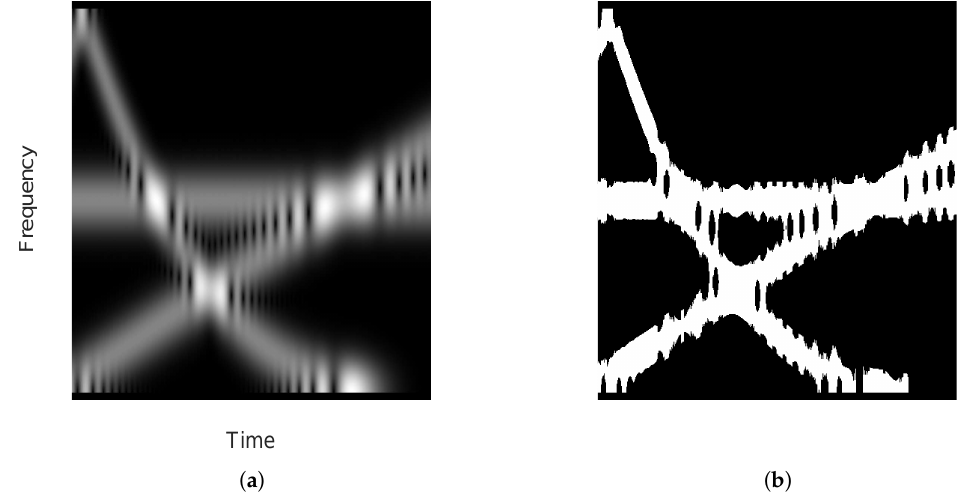
Figure 6. ( a ) Spectrogram of a three-component signal computed with a gaussian window with length s = 32. ( b ) Binary map derived from ( a ). A large number of black holes appears, as the spectrogram is very spread.